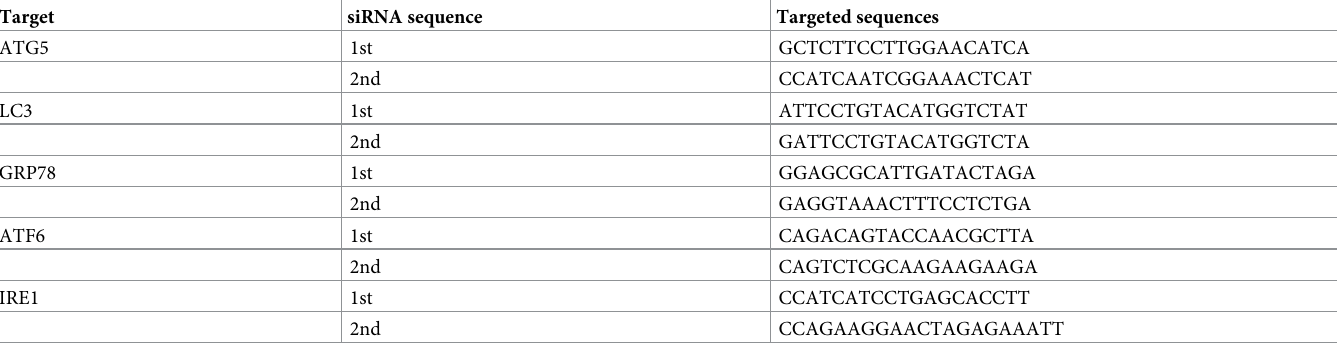
Table 1. The siRNA target sequences for ATG5, LC3, GRP78, ATF6 and IRE1 protein expression in ST cells.